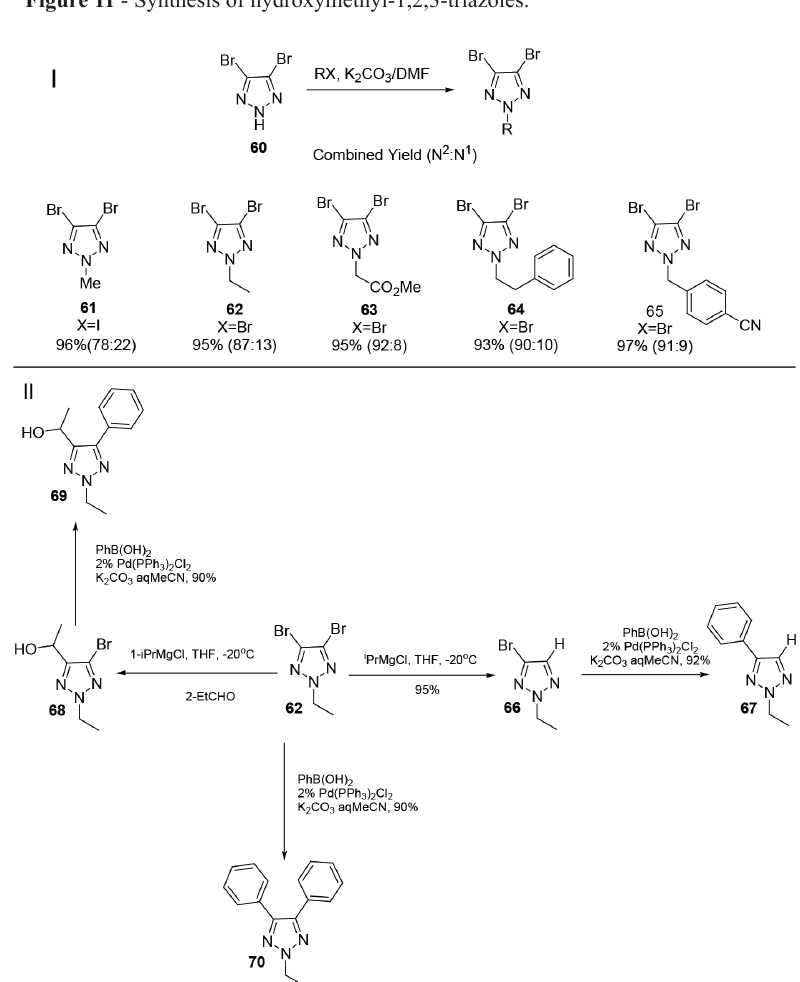
Figure 12 - I- Regioselective alkylation reaction with a 4.5-dibromo-1,2,3-triazole; II-examples of the transformtion of the N 2 -Alkyl- 4,5-dibromo-1,2,3-triazole into N 2 - Alkyl-4,5-alkyl(Aryl)-1,2,3-triazoles.